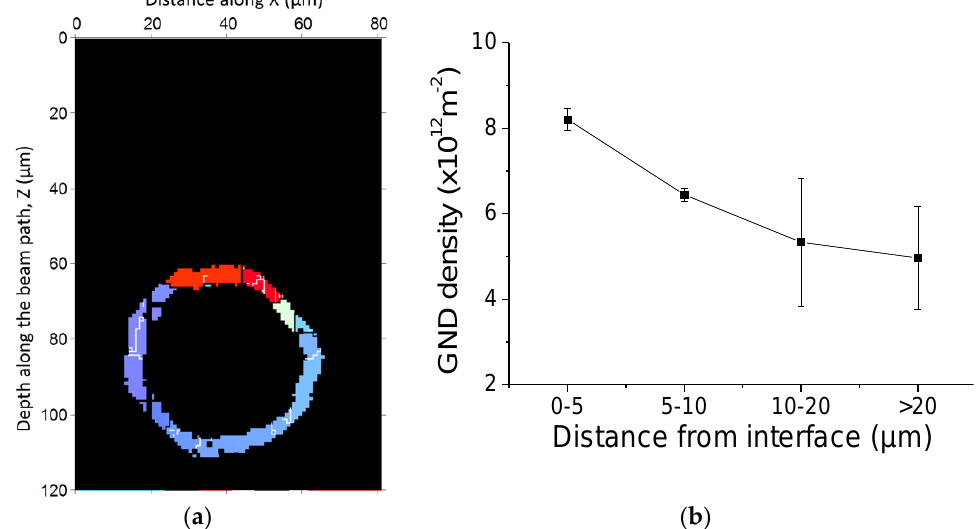
Figure 6. ( a ) An example illustrating the subset selection for the calculation of average geometrically necessary dislocation (GND) density: the region within 0 – 5 µm from the nodule/matrix interface for the nodule shown in Figure 4a. The colors in ( a ) are the same as in Figure 4a; ( b ) Average GND density for the matrix grains located at different distances from the nodule/matrix interface.